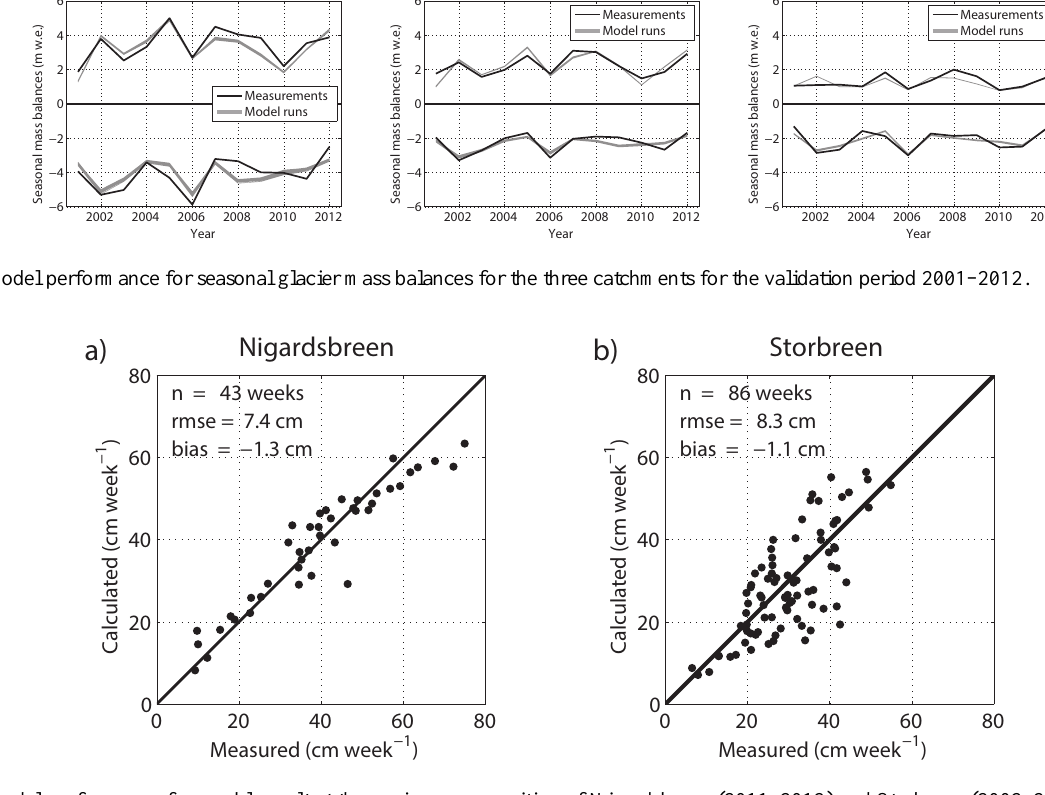
Fig. 5. Model performance for weekly melt at the sonic ranger position of Nigardsbreen (2011–2012) and Storbreen (2002–2012). Data for the modellings represent the mean of the best 100 model runs.